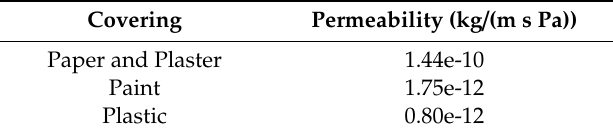
Figure 12. Indoor air enthalpy predicted for each internal covering during the summer season. Table 2. Permeability values of di ff erent types of coverings